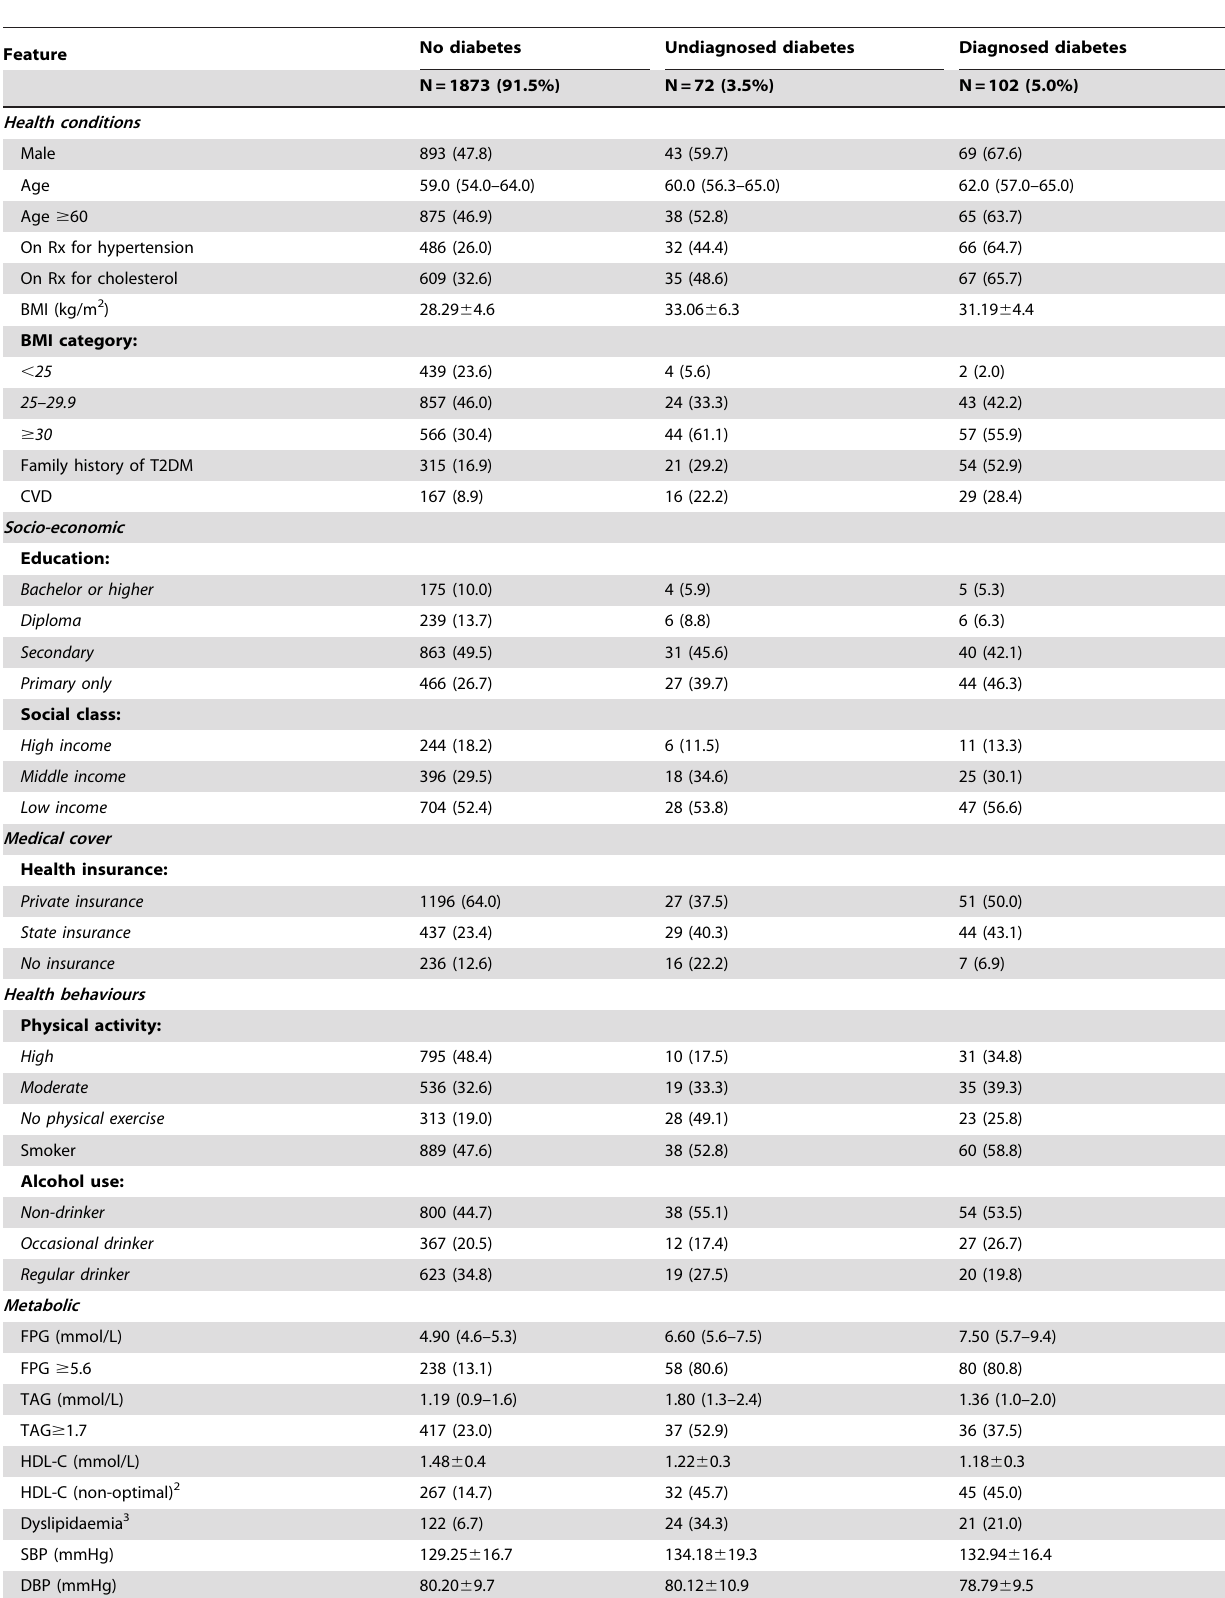
Table 1. Characteristics of the study population.